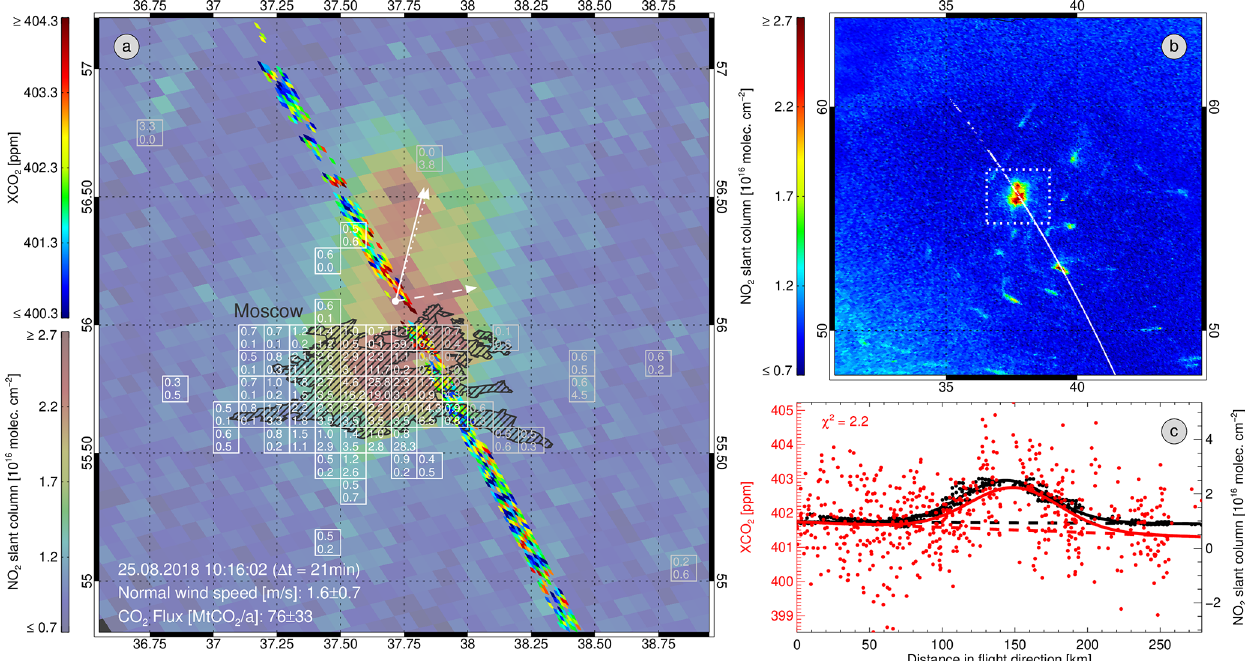
Figure 1. Moscow on 25 August 2018. (a) S5P NO 2 slant column (background, pale colors) overlaid by OCO-2 XCO 2 (foreground, saturated colors). Gray and white 0.1 ◦ boxes show EDGAR (bottom number in each box) and ODIAC (top number in each box) 2012 annual emissions with either EDGAR or ODIAC being larger than 0.5MtCO 2 a − 1 . The white arrows show the direction of the 10m wind as read from ECMWF (dotted), manually corrected to (subjectively) best match the NO 2 plume (solid), and normal to the OCO-2 orbit (dashed). Effective wind speed normal to the OCO-2 orbit, estimated cross-sectional CO 2 flux, time of OCO-2 overpass, and time difference between OCO-2 and S5P overpass are also listed. The hatched area corresponds to the urban area (World Urban Areas dataset, Geoportal of the University of California, https://apps.gis.ucla.edu/geodata/dataset/world_urban_areas). (b) Larger section of the S5P NO 2 slant columns including the OCO-2 orbit and the bounding box of (a) . (c) OCO-2 XCO 2 values (red) and co-located S5P NO 2 slant columns (black) within the plume’s cross section in OCO-2 flight